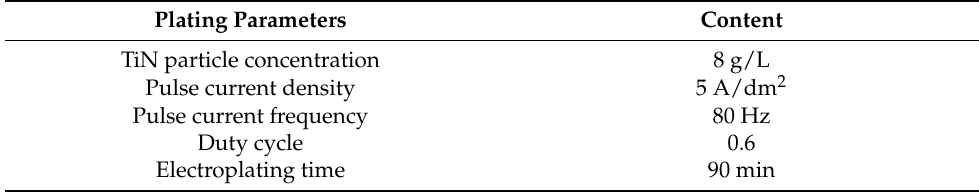
Figure 2. Schematic image of the pulse electrodeposition device. Table 1. Depositing parameters for obtaining Ni-TiN nanoplatings.